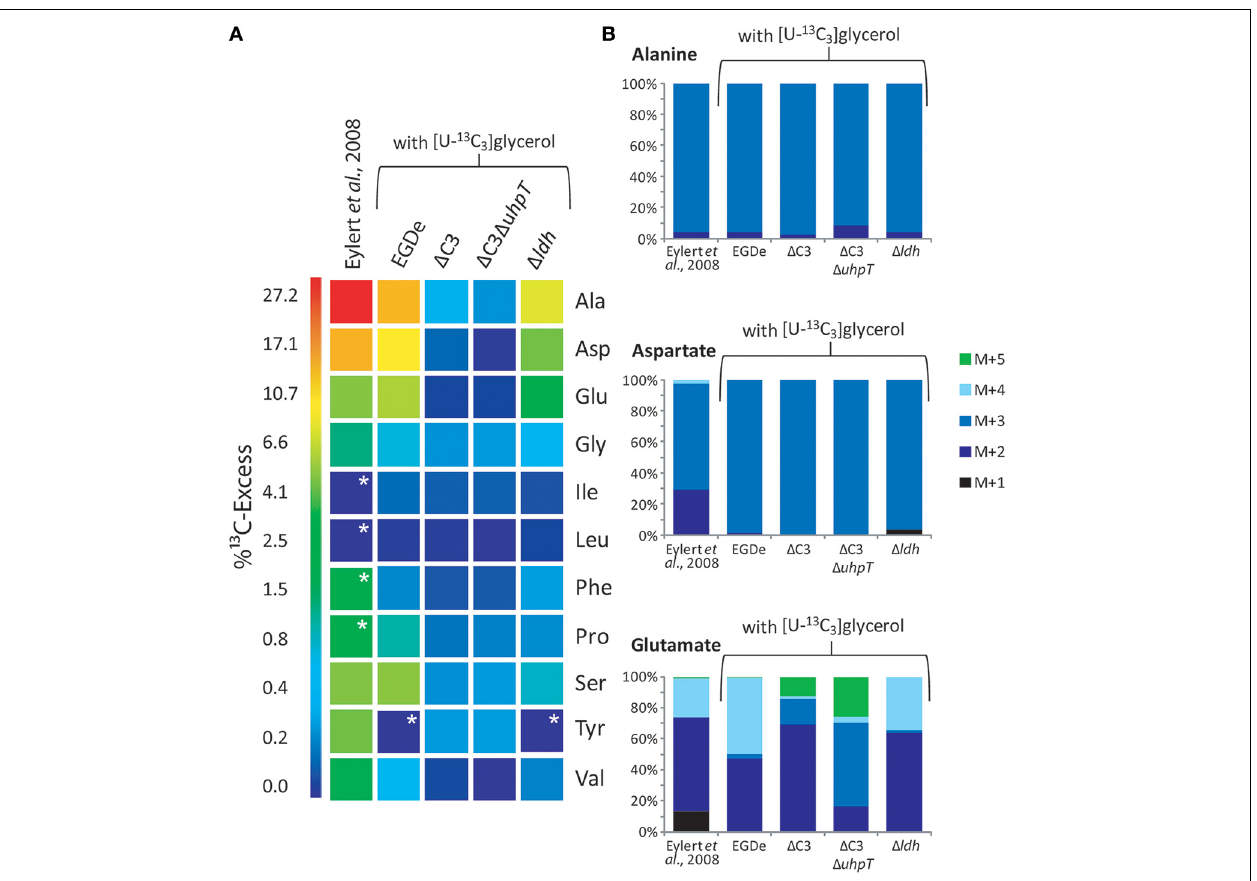
(cid:2) C3 mutant, column 4: from the labeling experiment with [U- 13 C 3 ]glycerol and the EGDe (cid:2) C3 (cid:2) uhpT mutant, and column 5: from the labeling experiment with [U- 13 C 3 ]glycerol and the EGDe (cid:2) ldH mutant. Boxes with white asterisks indicate high standard deviations in the measurement of the overall 13 C-enrichments. (B) Isotopologue profiles in listerial Ala, Asp, and Glu from the same experiments. The colored columns indicate the relative fractions (in %) of the 13 C-isotopologues (M + 1 to M + 5). For the numerical values, see Supplemental